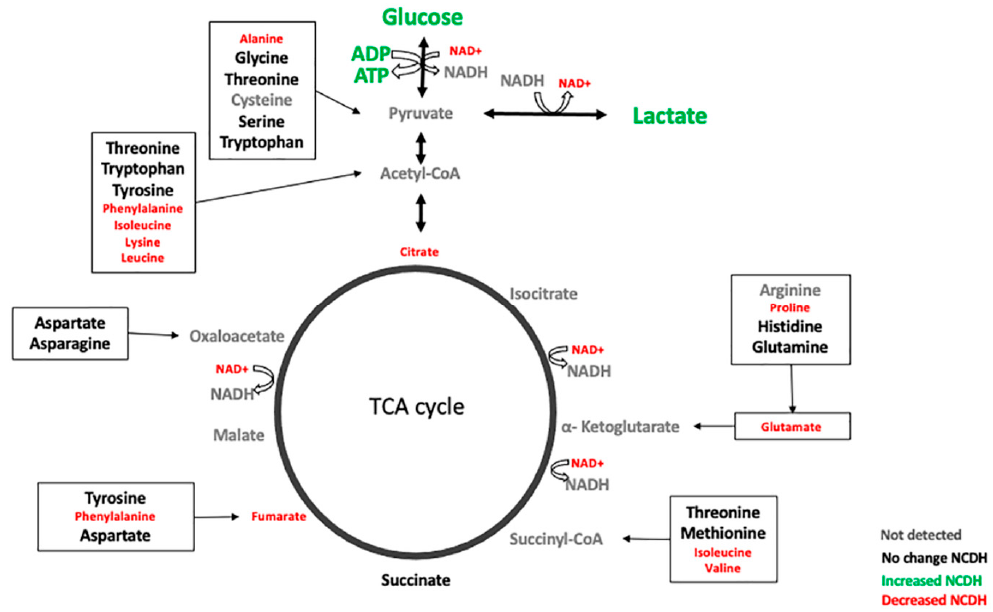
Figure 4. Modified glycolysis, TCA cycle, and amino acids “anaplerosis” in fetal CDH lungs. Schematic diagram of glycolytic, TCA cycle, and amino acids metabolites flow and the changes observed in the NCDH. Green (increased), red (decreased), black (no change), and grey (undetected).